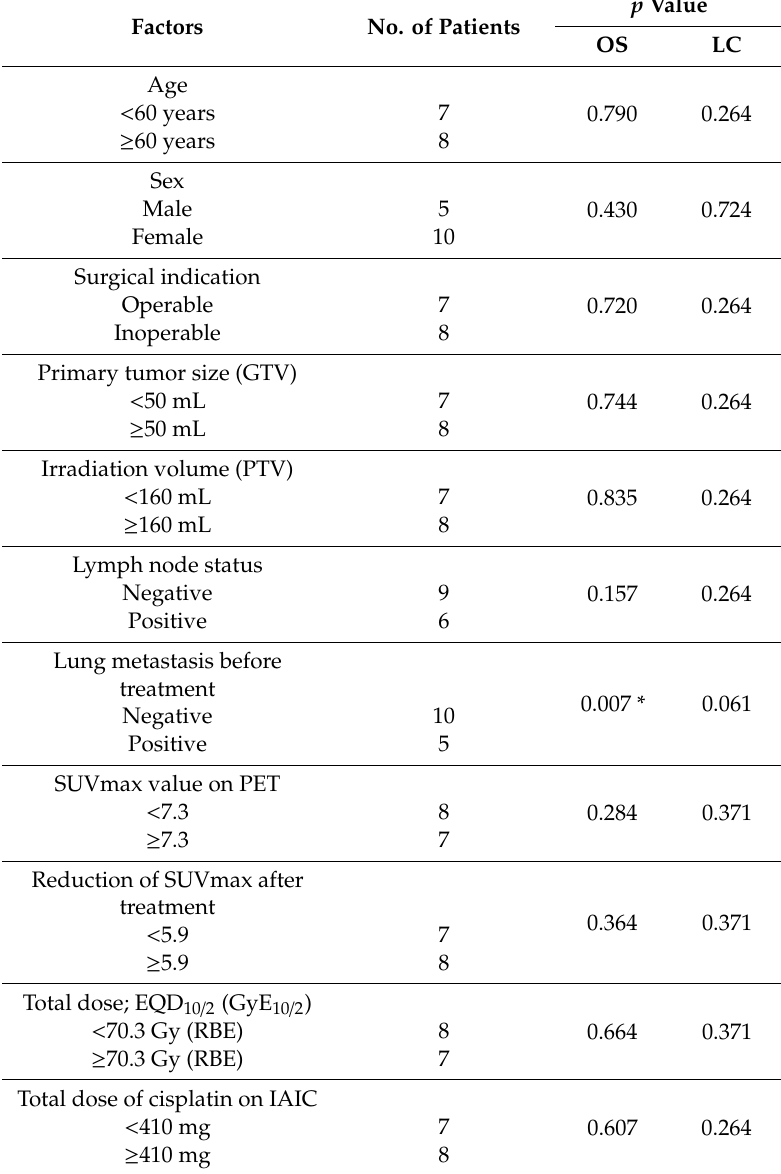
Table 3. Results of log-rank tests for prognostic